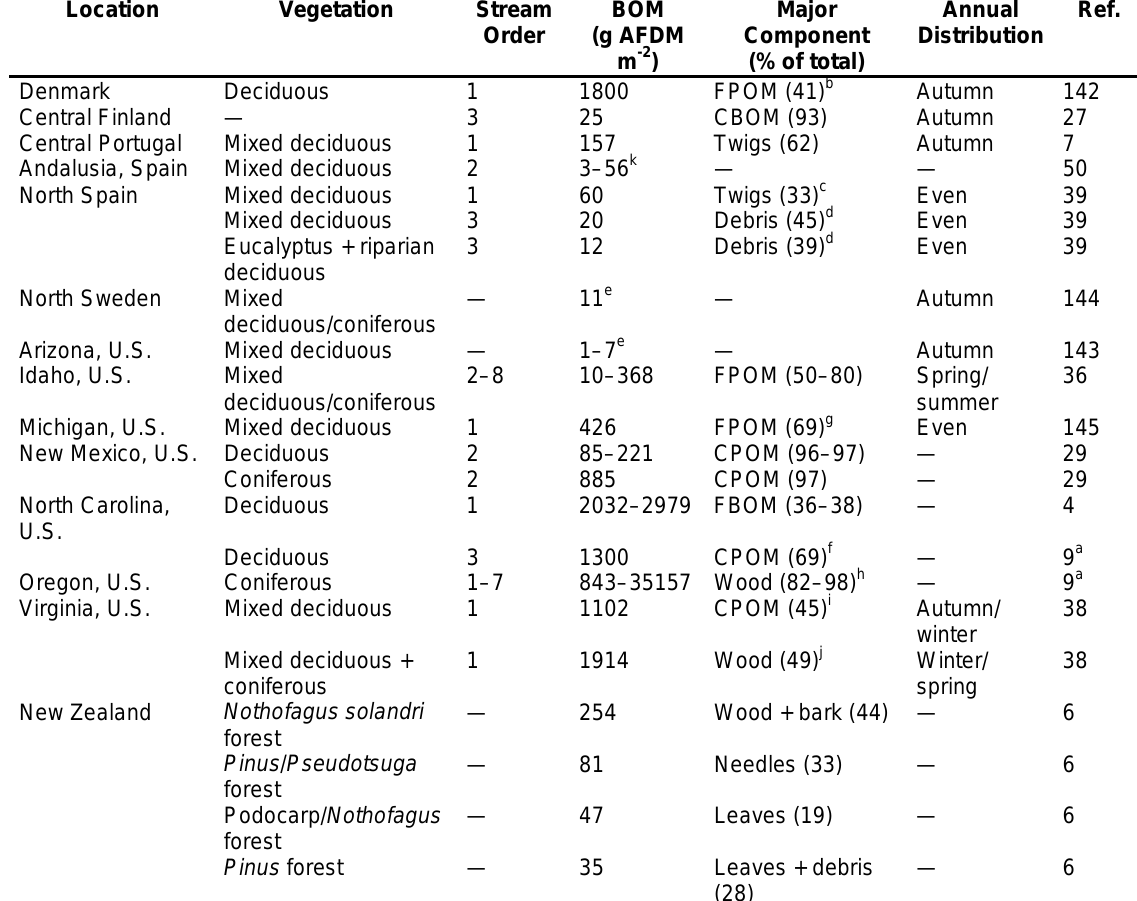
Mean Standing Stock of Benthic Organic Matter (BOM) in Streams of Different Geographic Areas